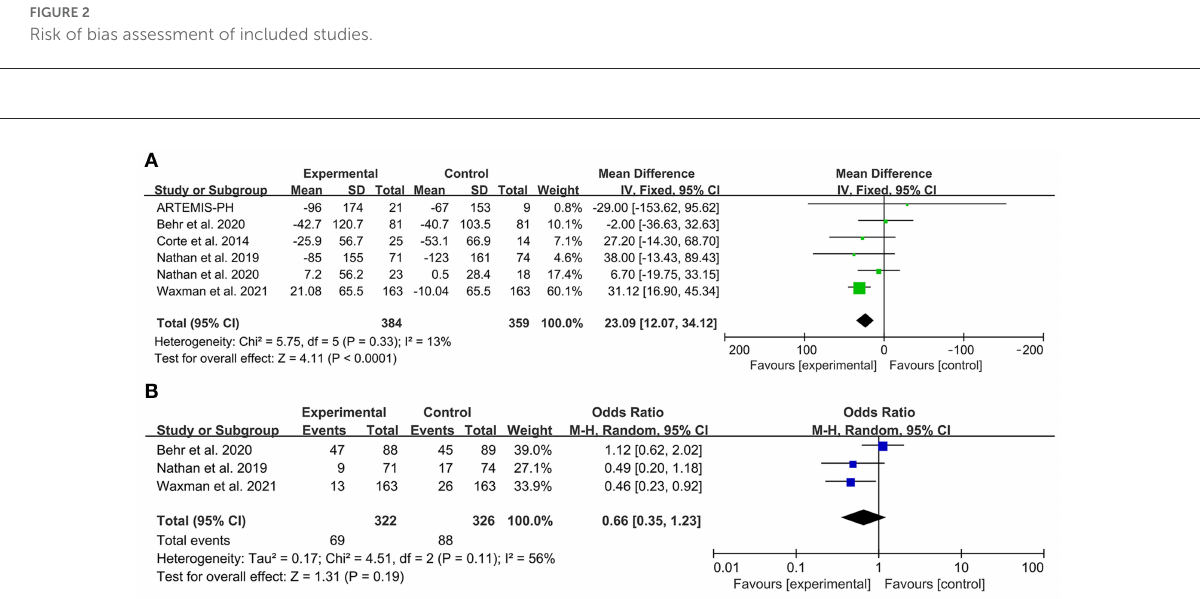
FIGURE3 Forest plot illustrating a comparison of effects of PAH-specific therapy on exercise capacity in PH-ILD. (A) Change of 6MWD from baseline. (B) Decline of 6MWD from baseline >